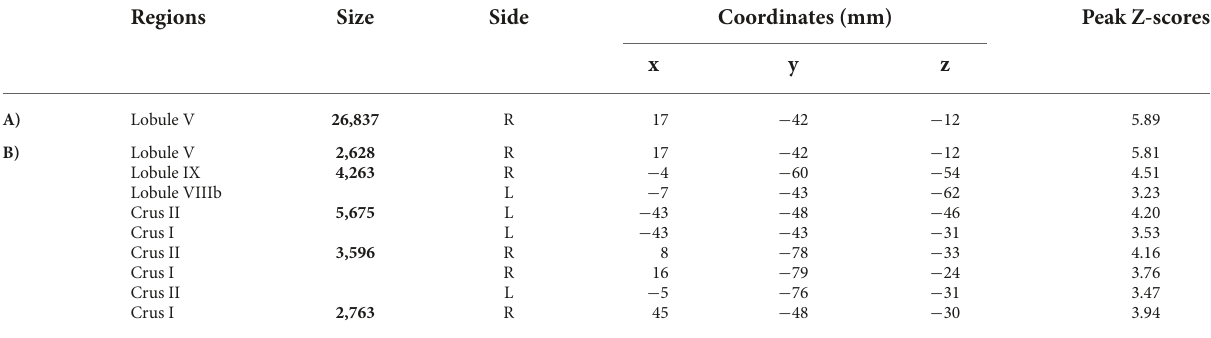
TABLE 5 Detailed statistics of voxelwise comparisons of cerebellar GM density (A: BD1 < HS-MRI; B: BD2 < HS-MRI). Regions Size Side Coordinates (mm) Peak Z-scores x